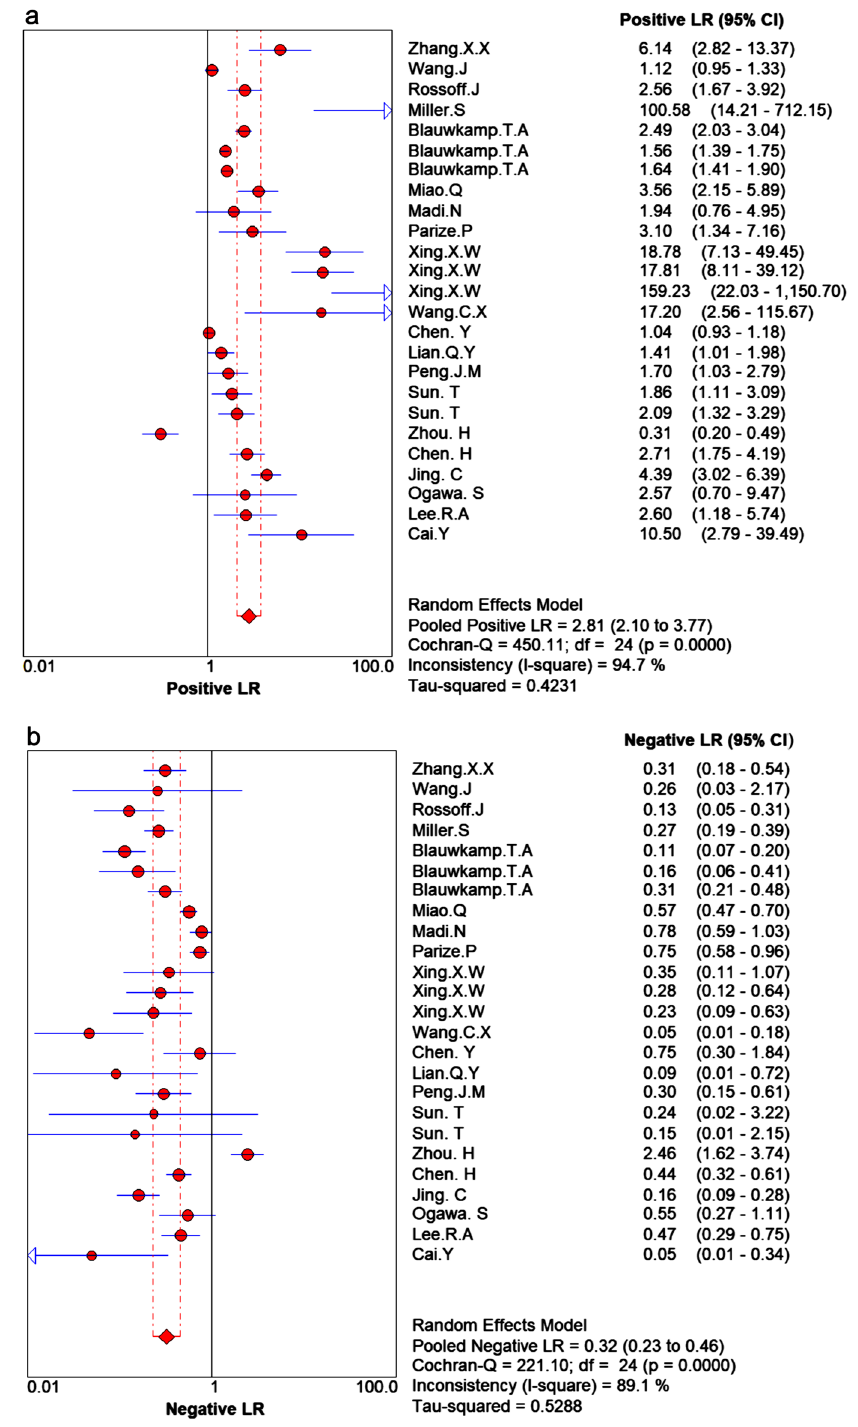
Figure 4. ( a ) Positive likelihood ratio; ( b ) Negative likelihood